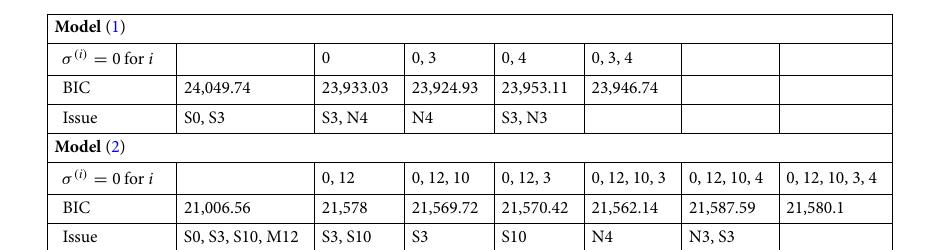
Table 2. Model specification under variable dropping. BIC values as well as corresponding issues leading to model exclusion are reported: S i , N i , M i stand for insignificance, negative marginal effect, and multicollinearity i ) driven by the corresponding variable ordered by σ ( ,